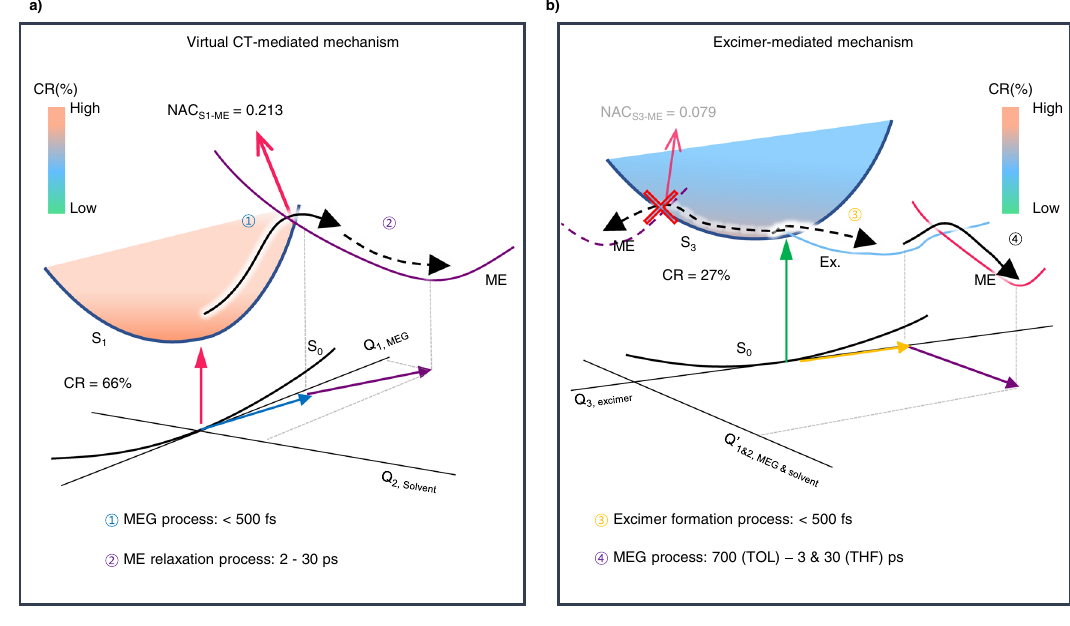
The colorbarindicatesthe relative CRcon fi gurationinthe respective states. Here, we suggest that the respective reaction coordinates (Q 1 , Q 2 , and Q 3 ) presumably correspondtothevibrationalmodesbasedontheexcited-stateRamaninFig.5.(Q 1 : high-frequency mode, Q 2 : RD and RB modes, and Q 3 : xOOP